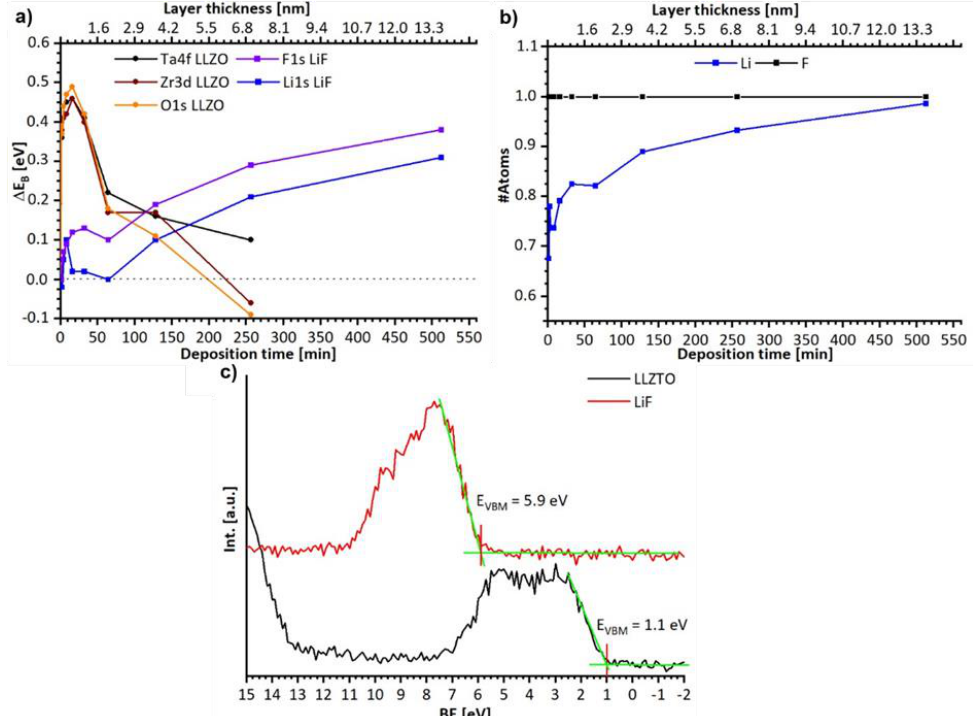
Figure 6. ( a ) Binding energy shift observed during the LLZTO-LiF interface experiment for LLZO and LiF on the basis of the Ta4f, Zr3d, and O1s positions for the LLZTO and F1s and Li1s for the LiF. ( b ) Lithium to fluorine ration determined by XPS during the interface experimented, referencing one fluorine. ( c ) Valence band spectra and EVBM position for LLZTO from the asis state and LiF after t = 512